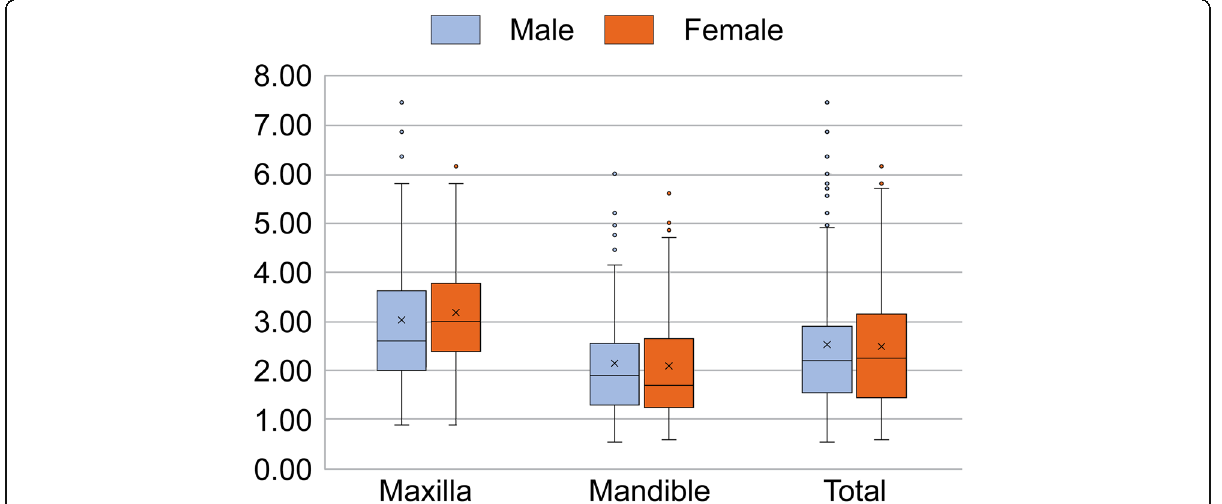
Fig. 4 Comparison of the mean mucosal thickness (MT) of edentulous sites according to jaw and